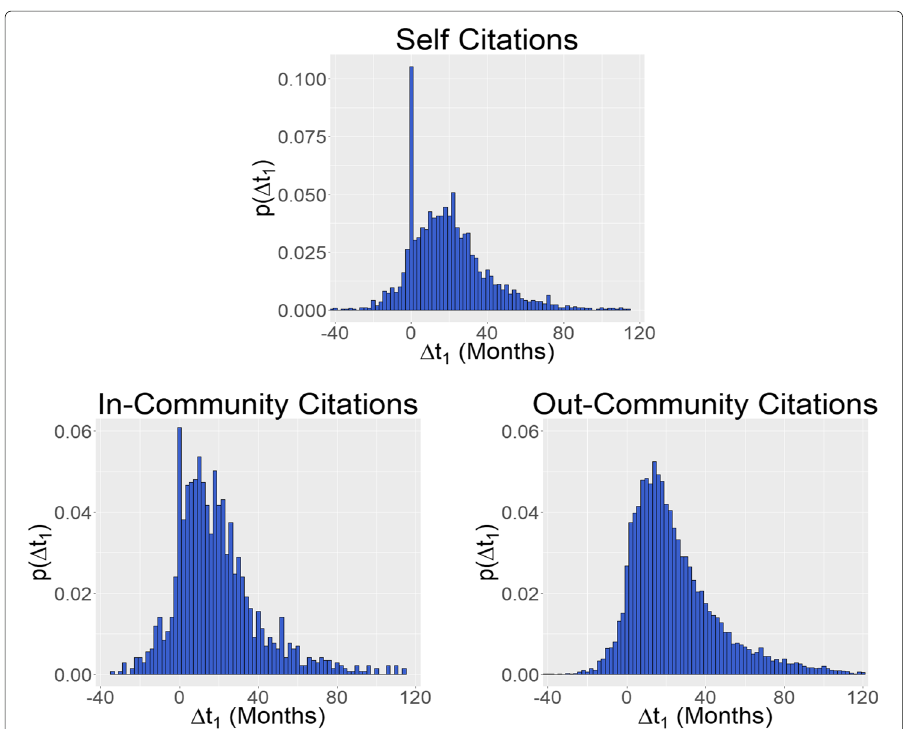
Fig. 3 Time to first citation differentiated according to origin of the first citation. The empirically obtained distributions of the time lag (cid:4) t 1 until first citation are shown for the three different categories of first citations considered in this work: self-citations, in-community citations, and out-of-community citations. Results shown here for the latter two types of citation have been obtained based on the community